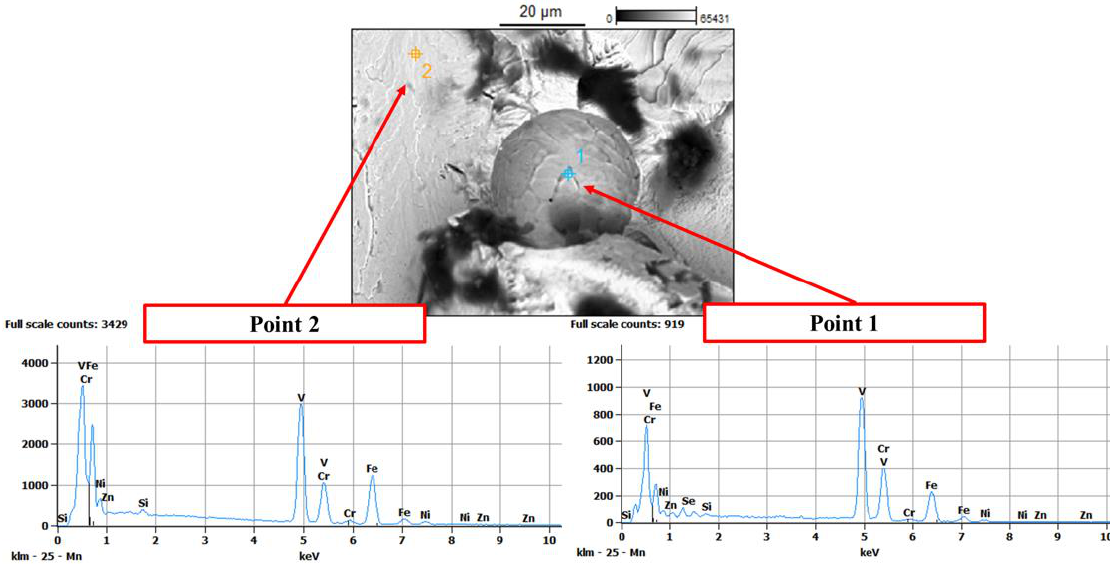
Figure 13. EDS of the specimen tested at ∆ σ = 200 MPa and failed at 192,951 cycles (specimen 7).